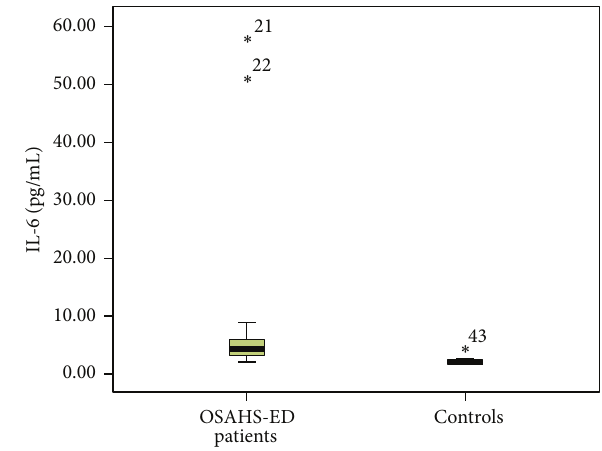
Figure 1: C-reactive protein (CRP) levels (mg/dL) are significantly higher in OSAHS patients with ED (OSAHS-ED) compared to controls ( 𝑃 < 0.001 ). CRP concentrations are shown as median (interquartile range) in the boxes.